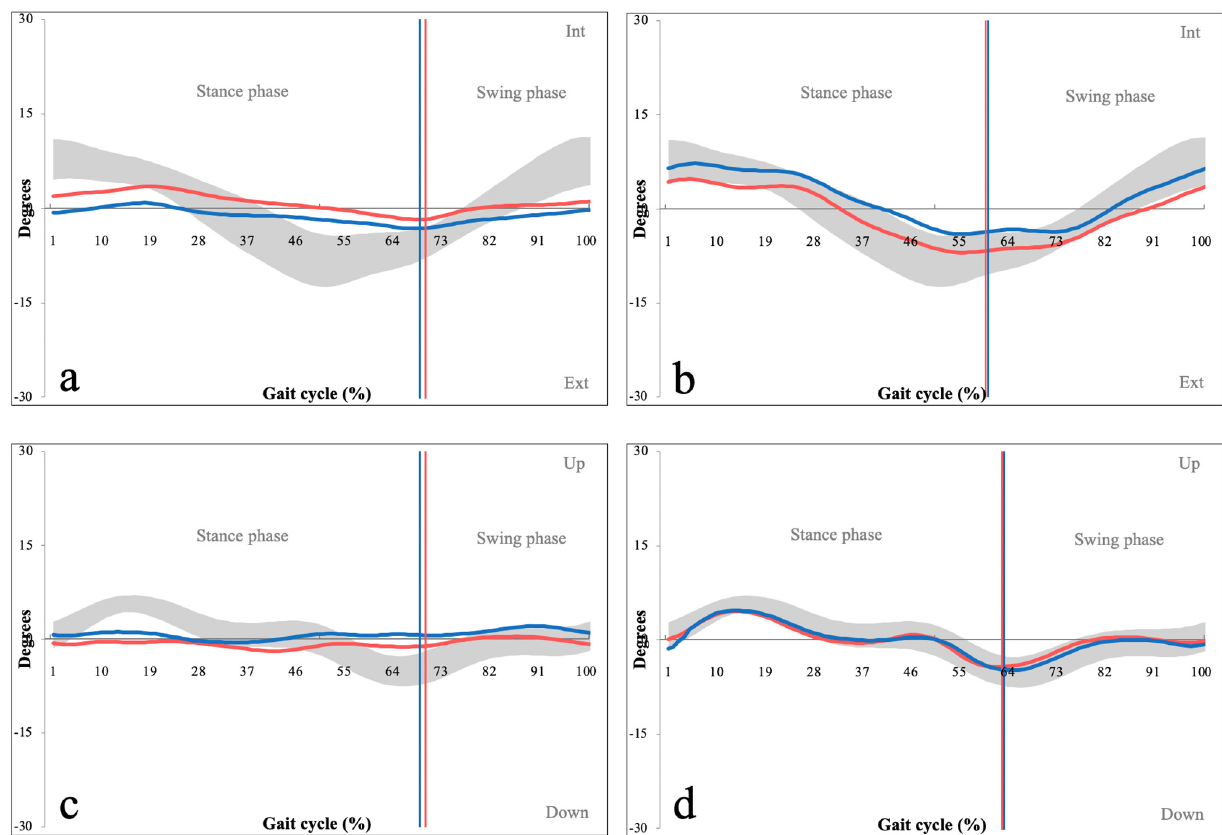
Figure 7. Kinematic graphs of pelvic internal/external rotation of a patient with LSS ( a ) and their matched control ( b ) as well as pelvic cranial/caudal movement of a patient with LSS ( c ) and their matched control ( d ). The graphs demonstrate increased pelvic rigidity throughout the gait cycle. Degrees of movement are shown on the vertical axis whereas the horizontal axis portrays the gait cycle. (Red line—left pelvic values, blue line—right pelvic leg values, grey space—normative values of pelvic internal/external rotation ( a ) and cranial/caudal movement ( b )).